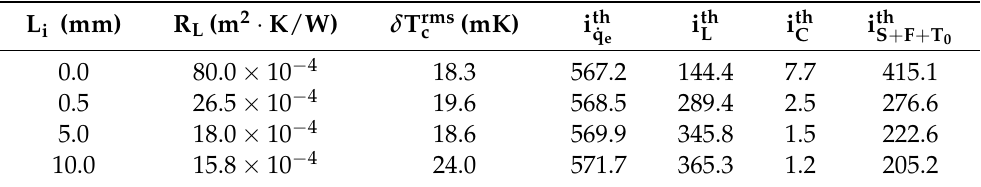
Table 4. NTC3 self-heating 1D modeling results, when immersed at L i in glycerol at rest, at T 0 = 25.0 ◦ C and v 0 = 6.90 V. The thermal power current densities values (in W · m − 2 ) were computed at t f = 30s and r = a c . The values of δ T rms c were calculated from the results shown in Figure